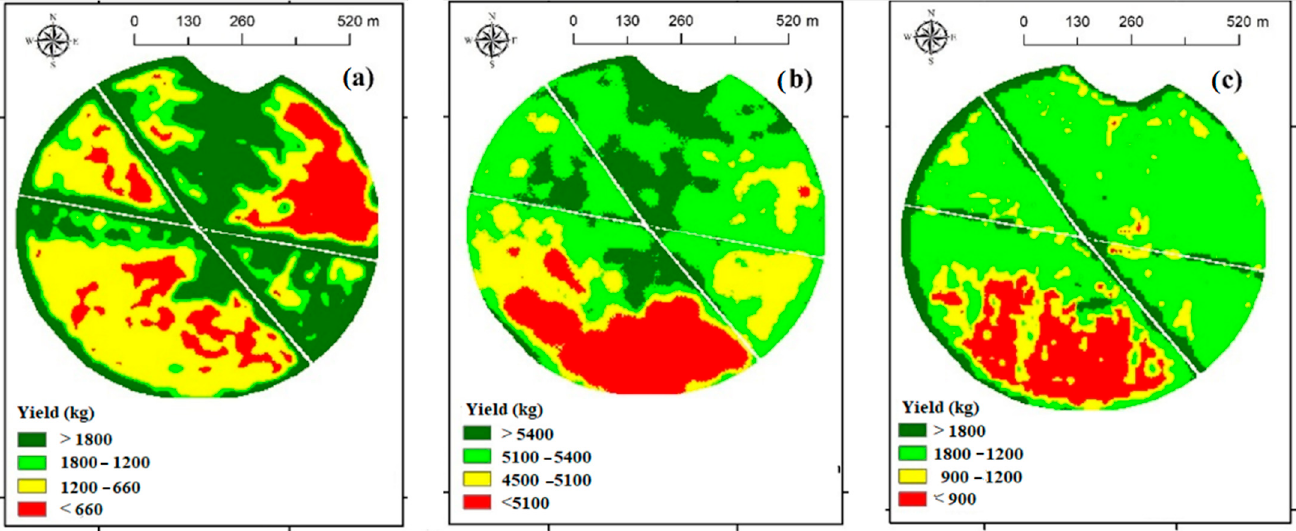
Figure 2. Spatial distribution of yield in the study area, derived from the RF algorithm applied to the bands/indices obtained from the Sentinel 2 satellite. ( a ) Yield for 2017; ( b ) yield for 2018; and ( c ) yield for 2019.